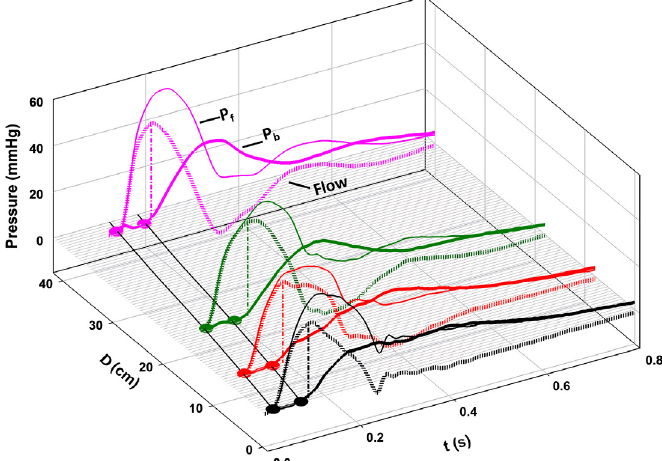
waveform at each location to the time of the peak of the flow waveform Figure 10. Comparison of the beginning of the P b (interrupted thick lines). Because the magnitudes of flow at each location were so different, they have been scaled arbitrarily to facilitate comparison (the flow at the aortic root was divided by 5; flows at just beyond the subclavian artery and at the